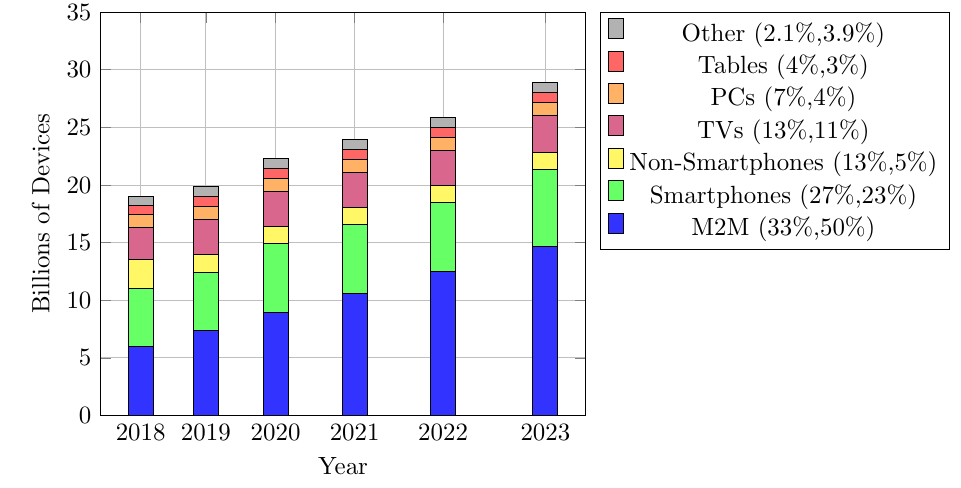
Figure 5. Global device and connection